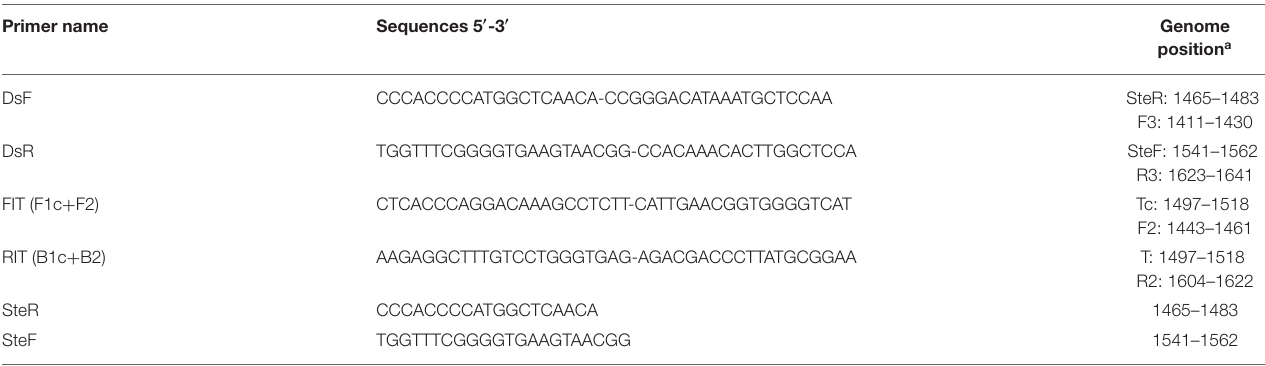
TABLE 1 | Primers of the colorimetric IMSA assay for PCV3.